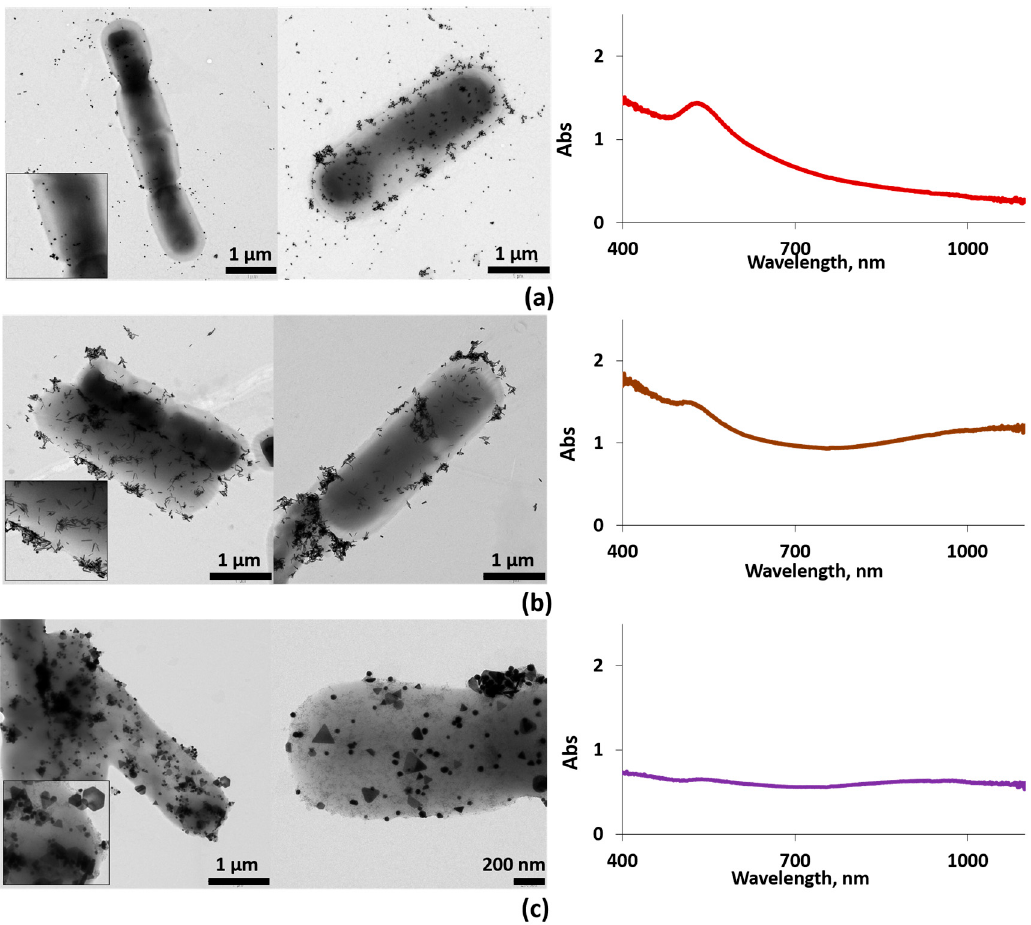
Figure 3. Left column: typical EM images for AuNSs–ferment ( a ), AuNRs–ferment ( b ), and AuNPRs–ferment ( c ). Several EM images are shown for each sample. Insets: zoom of the EM images. Right column: the corresponding UV-vis spectra of each sample, AuNSs–ferment ( a ), AuNRs–ferment ( b ), and AuNPRs–ferment ( c ).